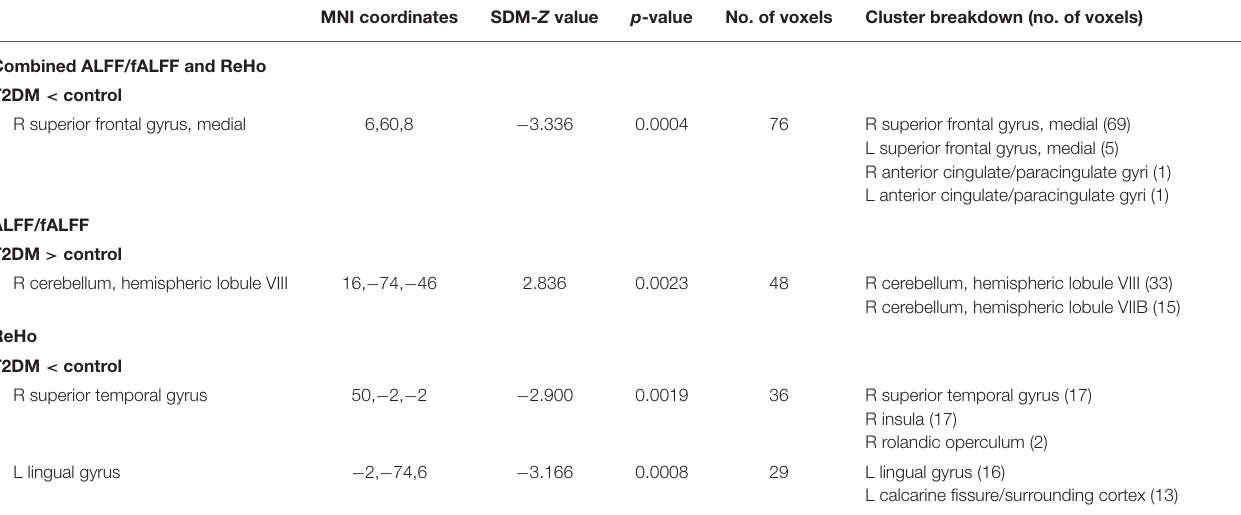
TABLE 2 | Meta-analysis results for patients with T2DM relative to healthy